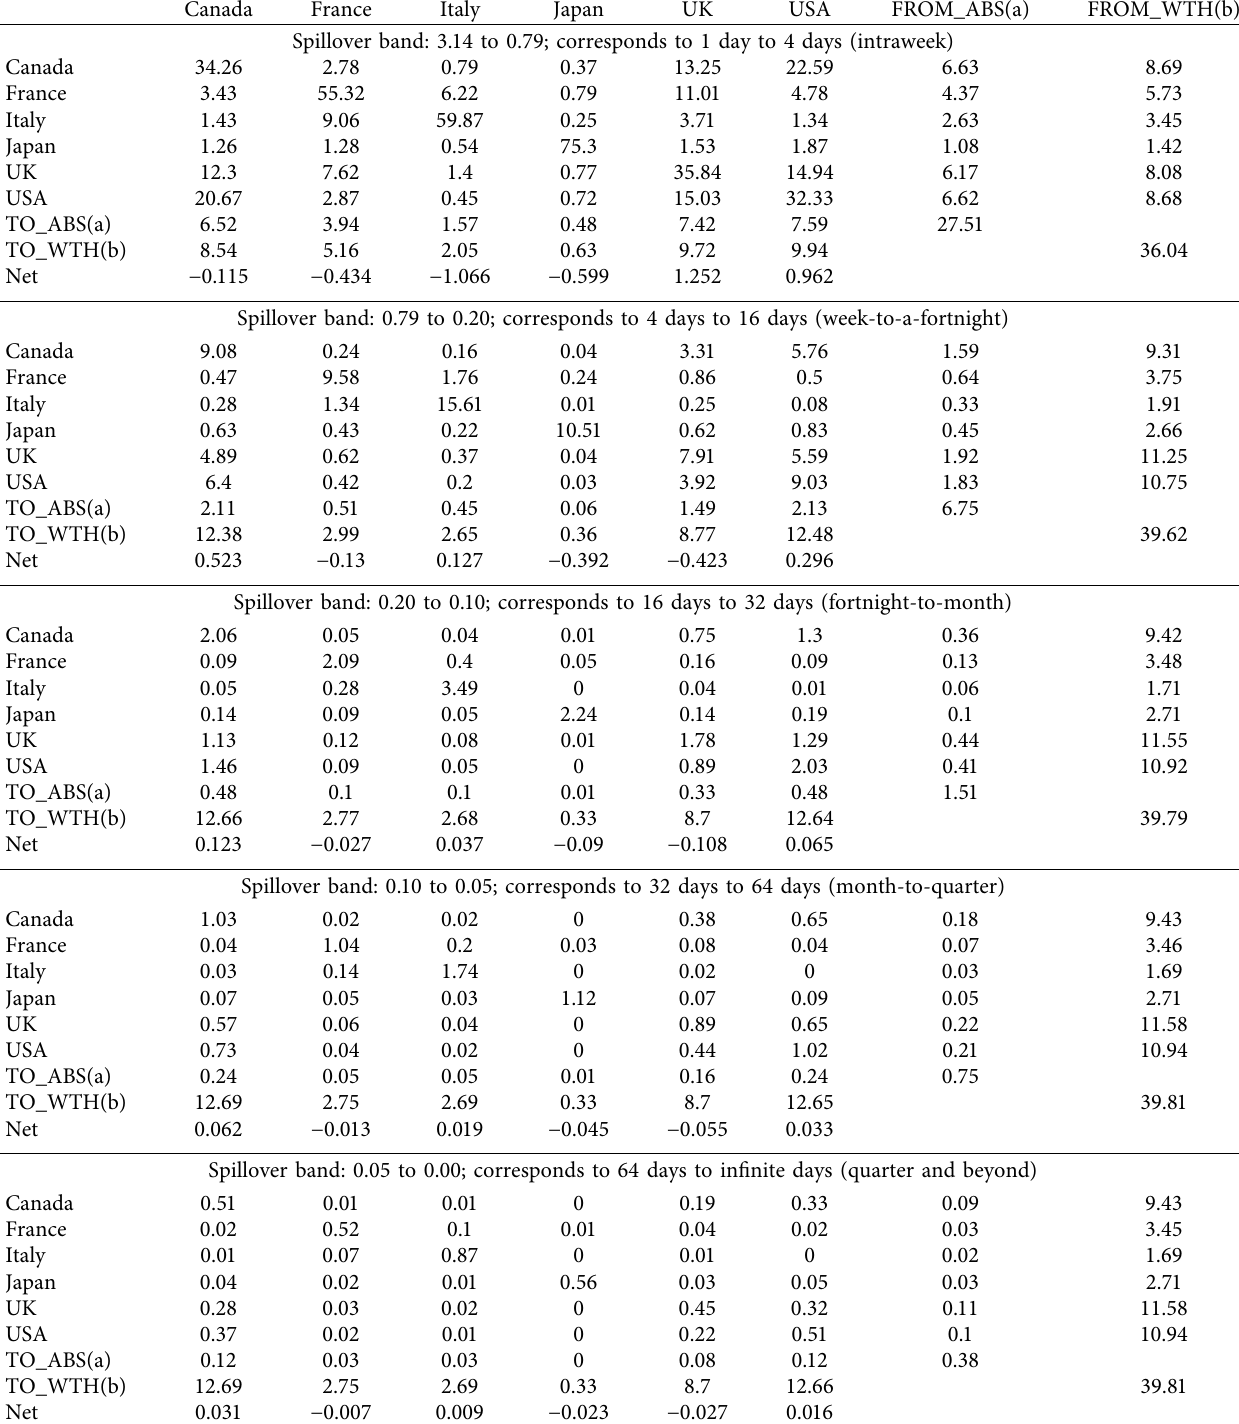
Table 5: Total and Net spillover indices across frequency bands for G6